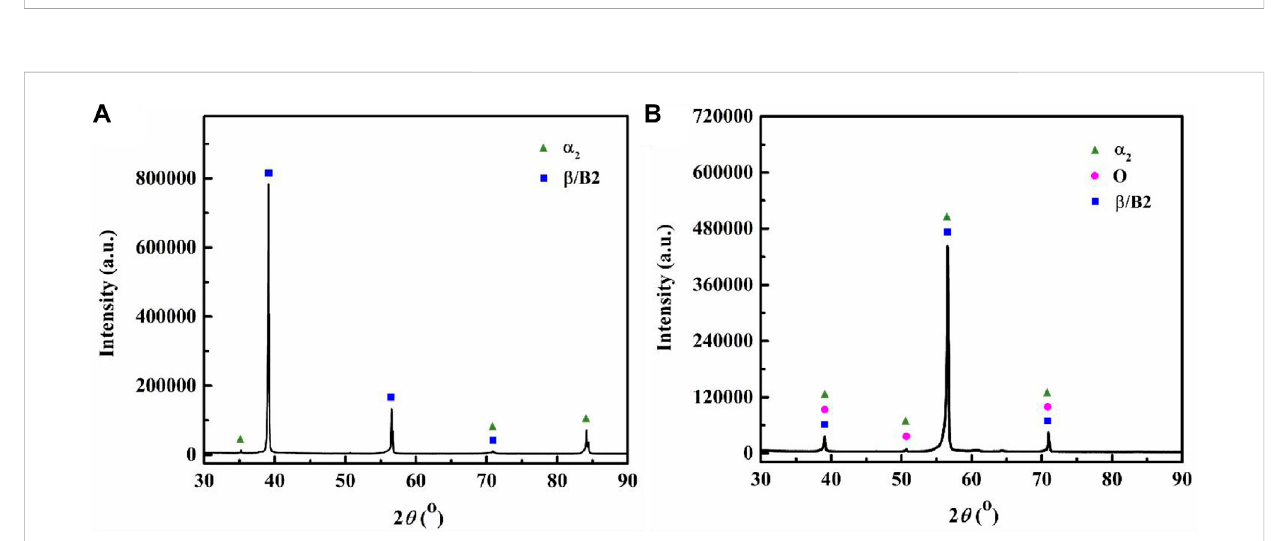
shear modulus is an index of ductility; the larger the ratio, the higher the ductility (Tanaka et al., 1996). The B / G ratio of the three different phases in the weld joint of Ti-22Al-25Nb alloy (Table 2) shows that the ductility of the β /B2 phase is the highest, α 2 phase second, and O phase lowest.